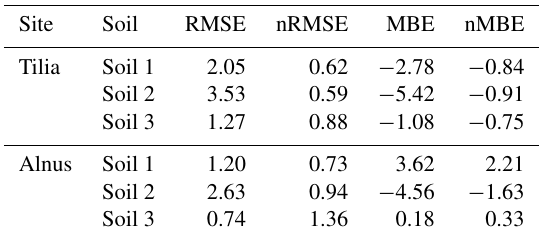
Table 5. Yasso model performance statistics for soil carbon stock at the Tilia and Alnus sites by soil